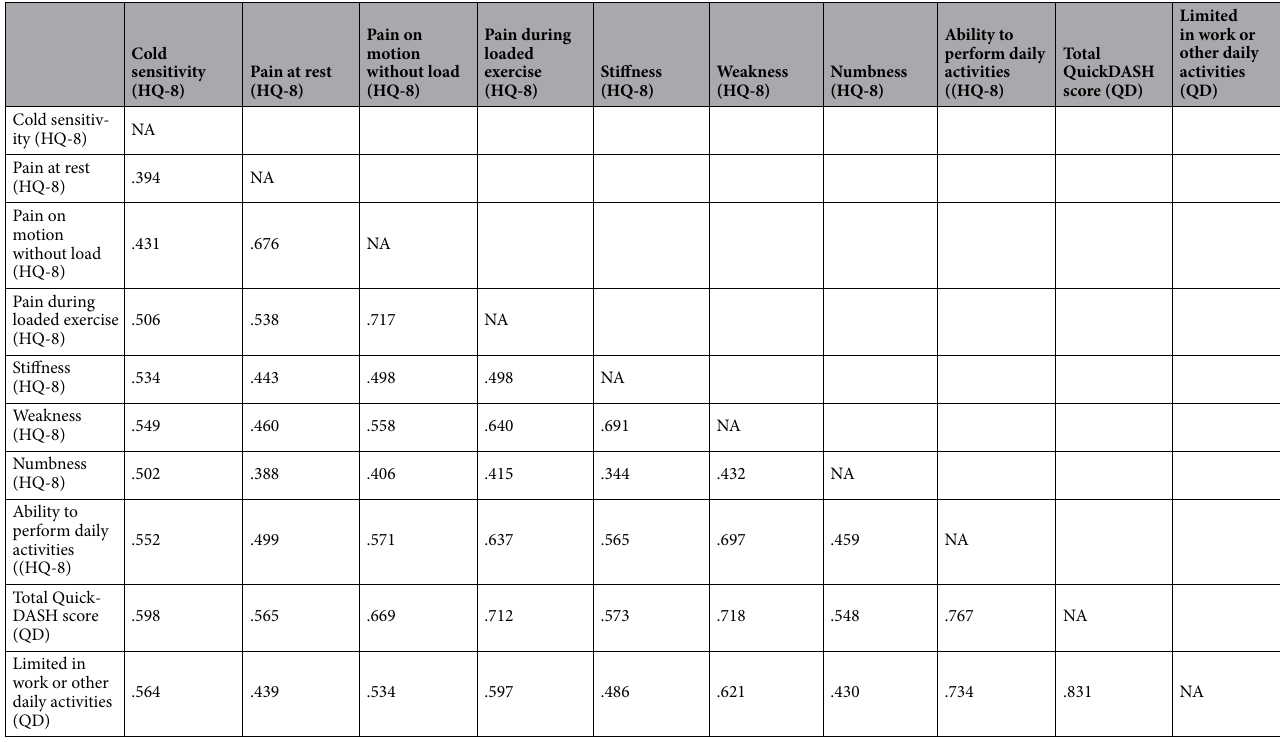
Table 3. Correlation between cold sensitivity and other HQ-8 symptoms, n = 786. Data are rho-values (Spearman rank test). Only rho-values > 0.3 are presented (i.e. no weak correlations). Rho-values 0.3–0.7: moderate and > 0.7: strong correlation. All p -values < 0.001.